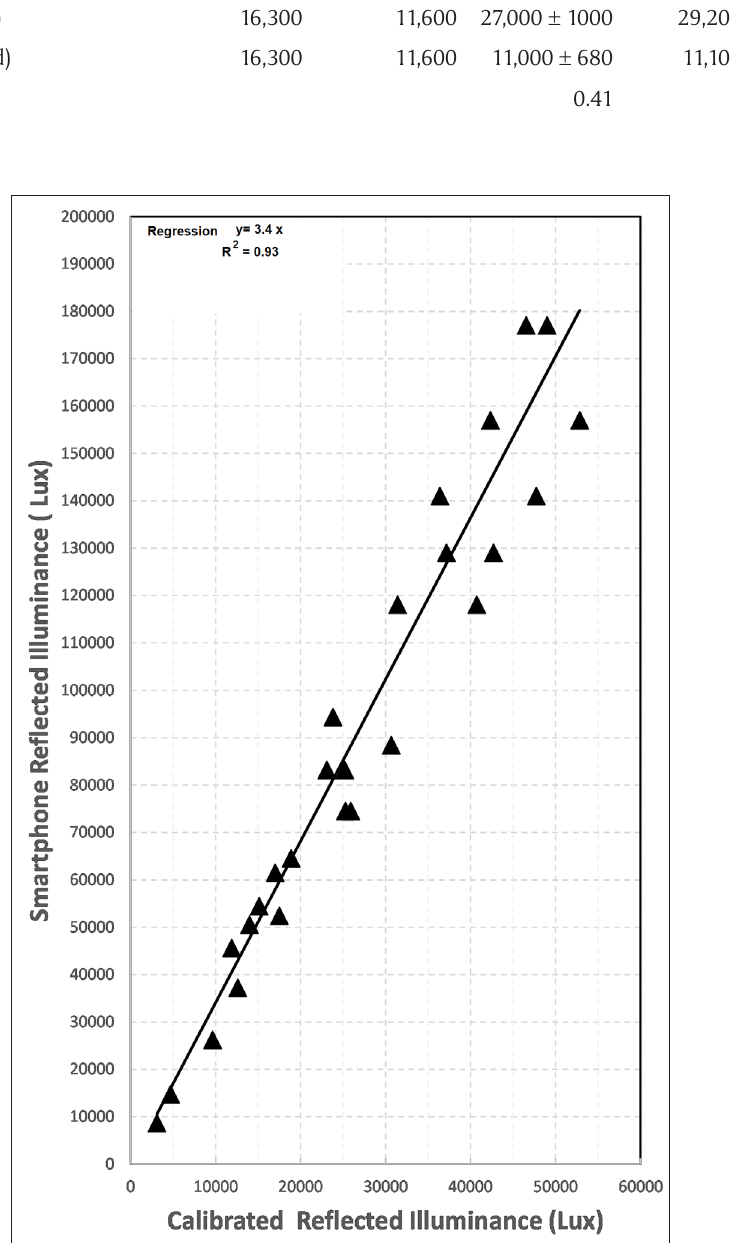
Figure 2: Comparison of reflected illuminance levels between calibration (LT-300) and iPhone 6s camera-based Galactica app ( triangle